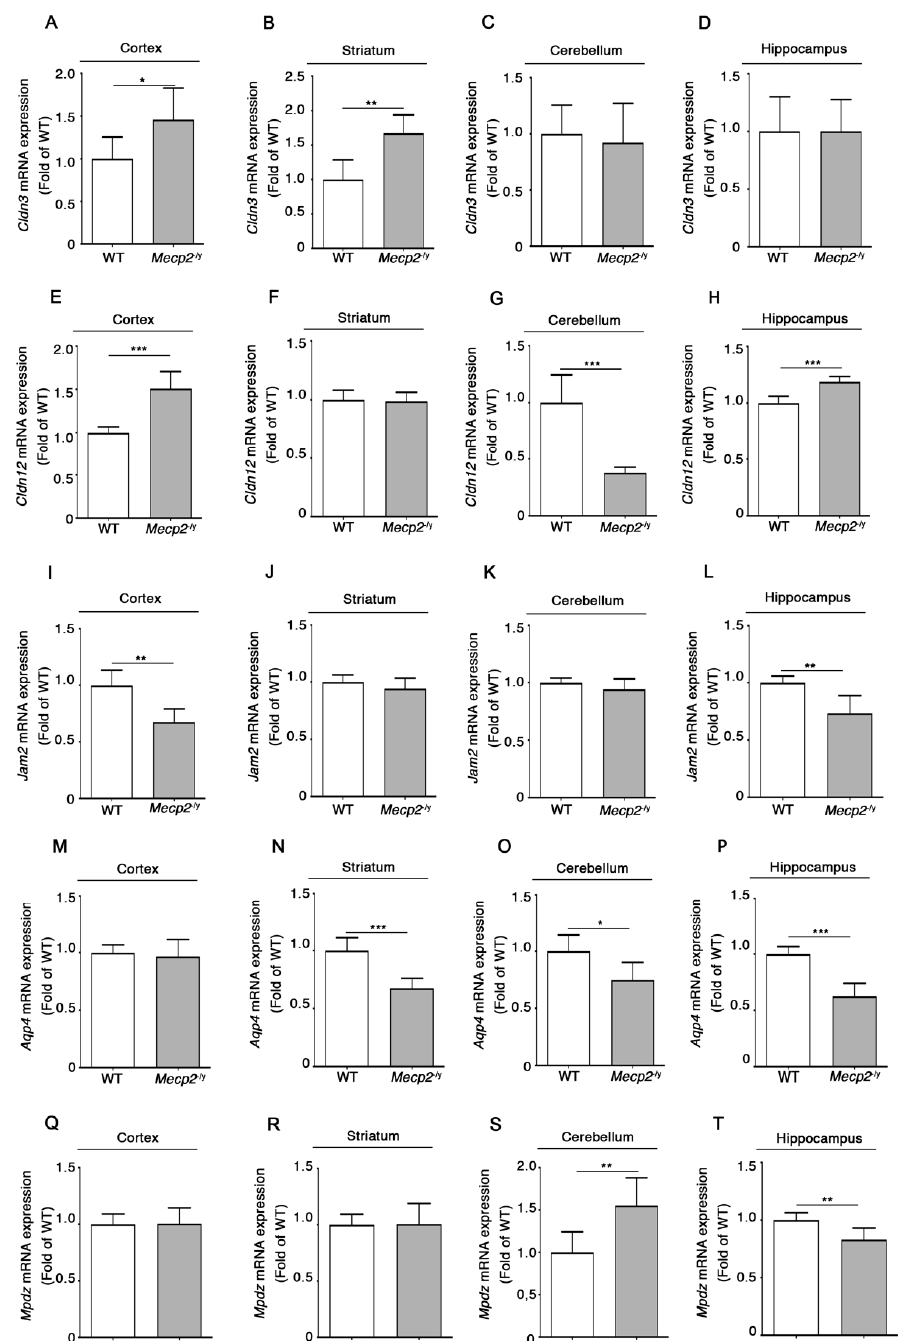
Figure 4. Expression of several genes involved in the regulation of structure and function of the BBB is perturbed in brain tissues of Mecp2 -/y mice. qPCR analysis of Cldn3 , Cldn12, Jam2, Aqp4, and Mpdz in cortex ( A , E , I , M , Q ), striatum ( B , F , J , N , R ), cerebellum ( C , G , K , O , S ), and hippocampus ( D , H , L , P , T ) of Mecp2 -/y mice and age-matched WT littermates. Data were normalized to Gapdh. Values are represented as mean ± SD. N= 6 for each group of mice. *, p < 0.05; **, p < 0.01, ***, p < 0.001 (two-tailed unpaired t